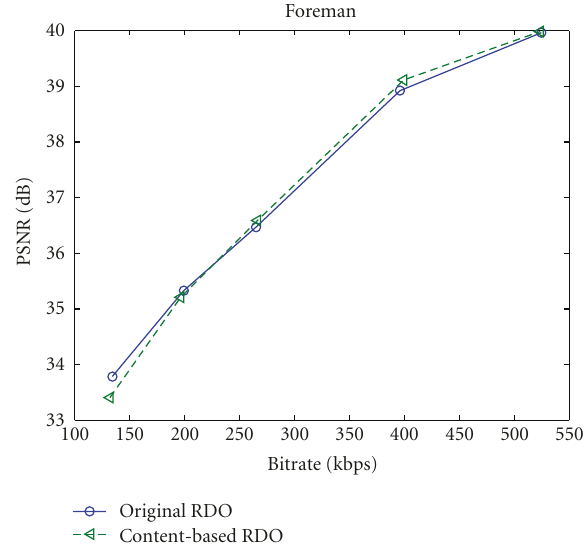
Figure 3: Comparison of PSNR results between the reference software and the proposed scheme for